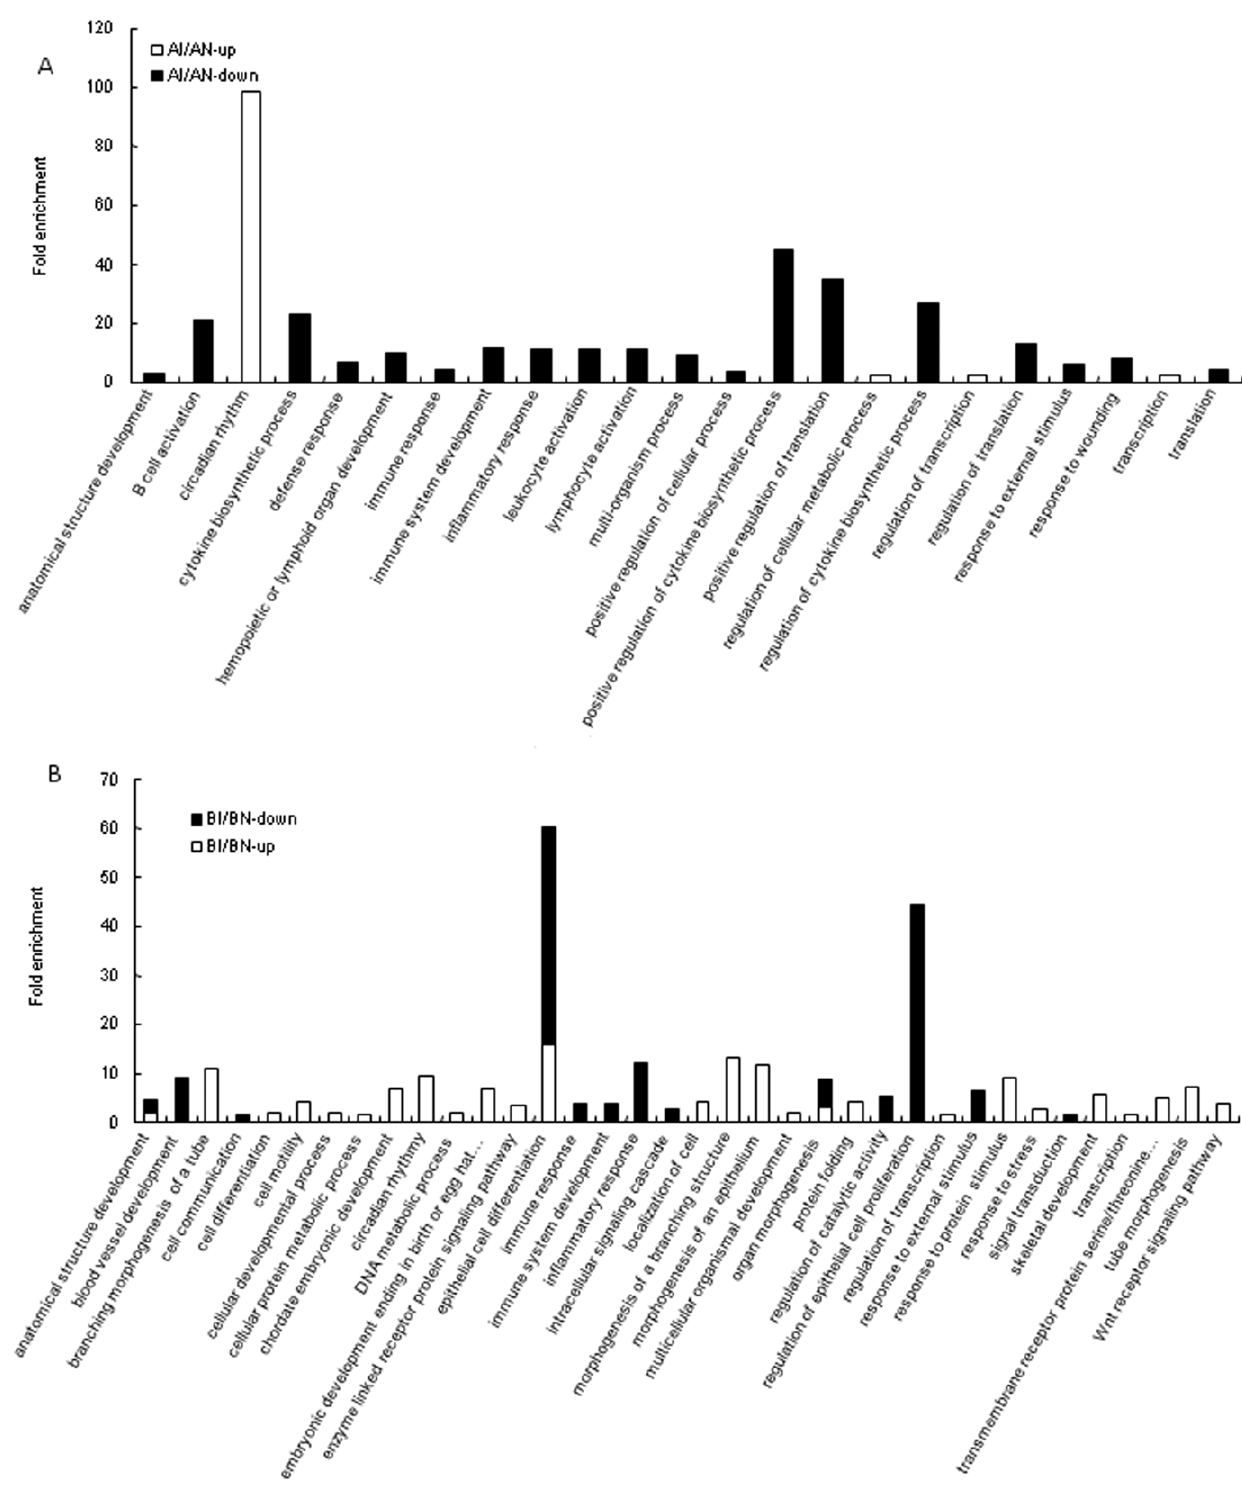
Figure 4. Enriched BP GO terms for significantly expressed genes between inoculated and non-inoculated birds within lines. A: Enriched BP GO terms in the comparison of AI/AN. B: Enriched BP GO terms in the comparison of BI/BN. Note: embryonic development ending in birth or egg hat… represents embryonic development ending in birth or egg hatch; transmembrane receptor protein serine/threonie… represents transmembrane receptor protein serine/threonine kinase signaling pathway.